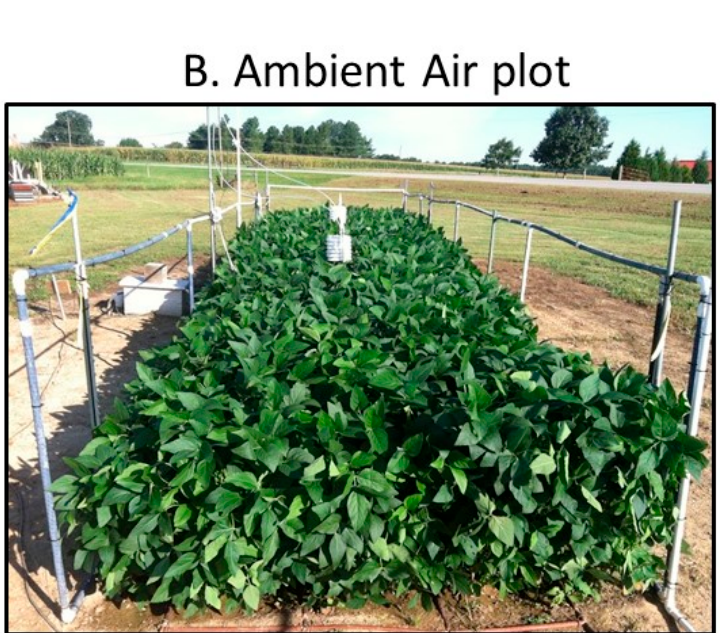
Figure 1. An air exclusion system (AES) plot ( A ) and an ambient air plot ( B ). Conditioned air is supplied to the AES plot through double-wall panels on each side of the plot with fan boxes providing a continuous flow of air throughout the season. The air flow in the ambient air plot is dependent on natural wind speed and direction. See text for a detailed description of the features.